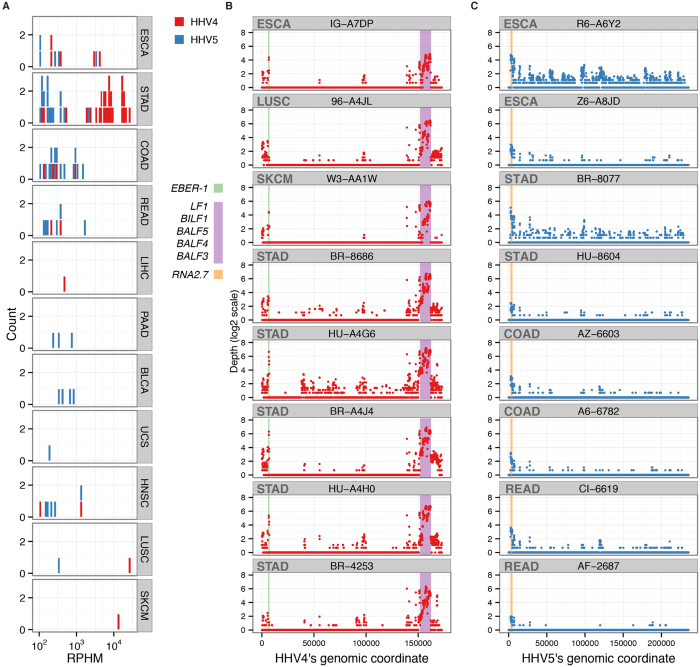
(A) The histogram of HHV4 and HHV5-postive samples across different cancer types. Comparison of depths for two different viruses: (B) HHV4, and (C) HHV5, across the entire virus genome. X-axis is genomic position and y-axis is the calculated sequencing depth.